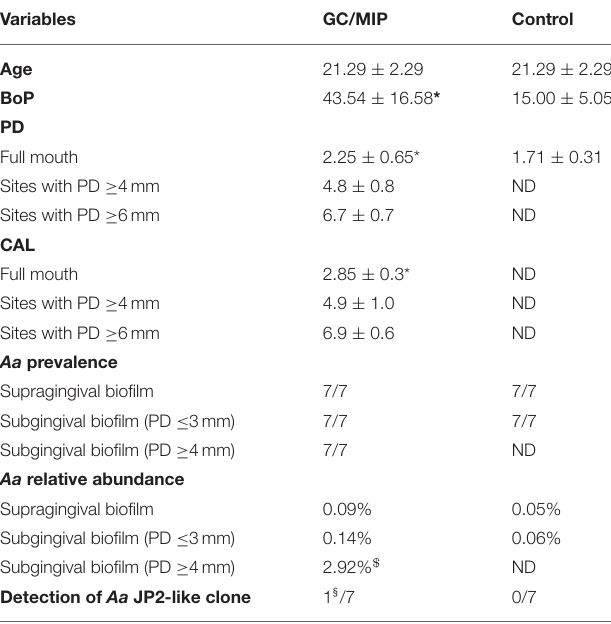
TABLE 1 | Demographic/periodontal clinical parameters and A. actinomycetemcomitans ( Aa ) prevalence and abundance in the oral